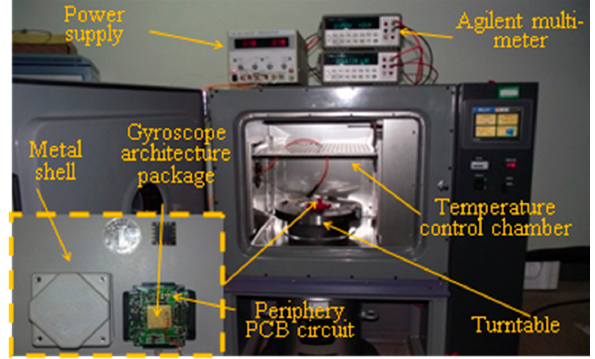
Figure 5. Test equipments for dual mass MEMS gyroscope.